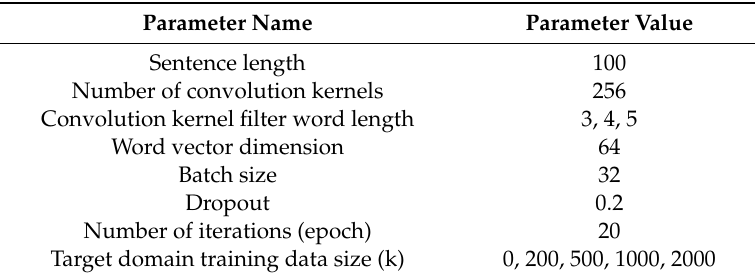
Table 3. CNN parameter settings.